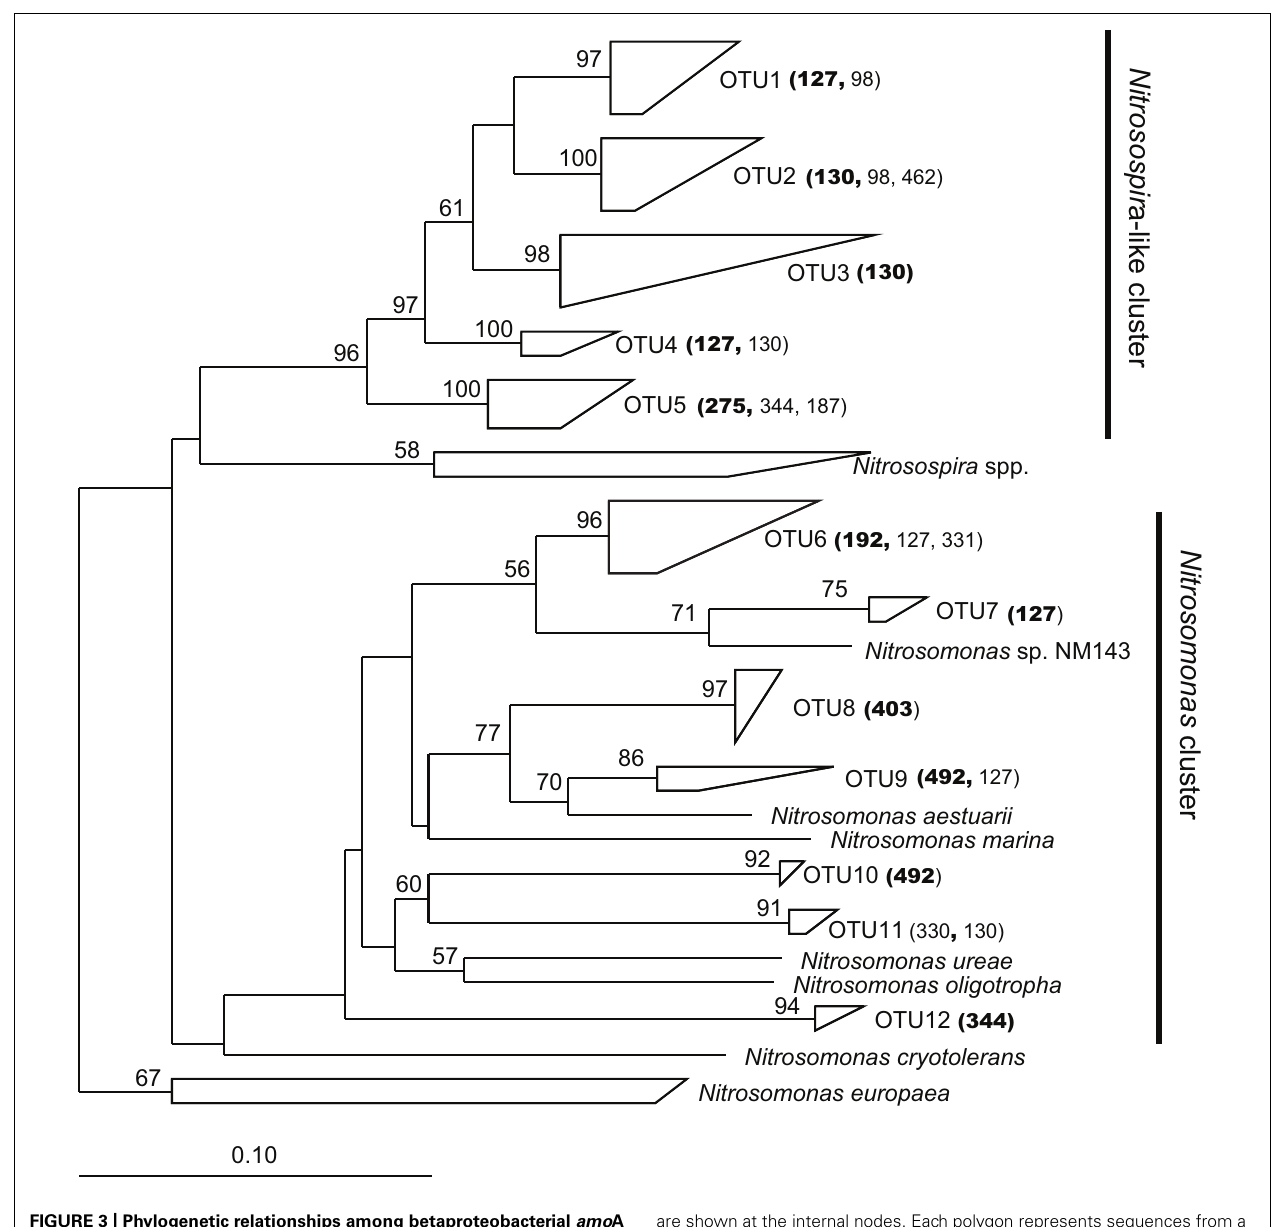
are shown at the internal nodes. Each polygon represents sequences from a single OTU with theTRF sizes of the sequences (number of base pairs determined in silico ) indicated parenthetically.TRF sizes representing ≥ 85% of the sequences in the cluster are shown in